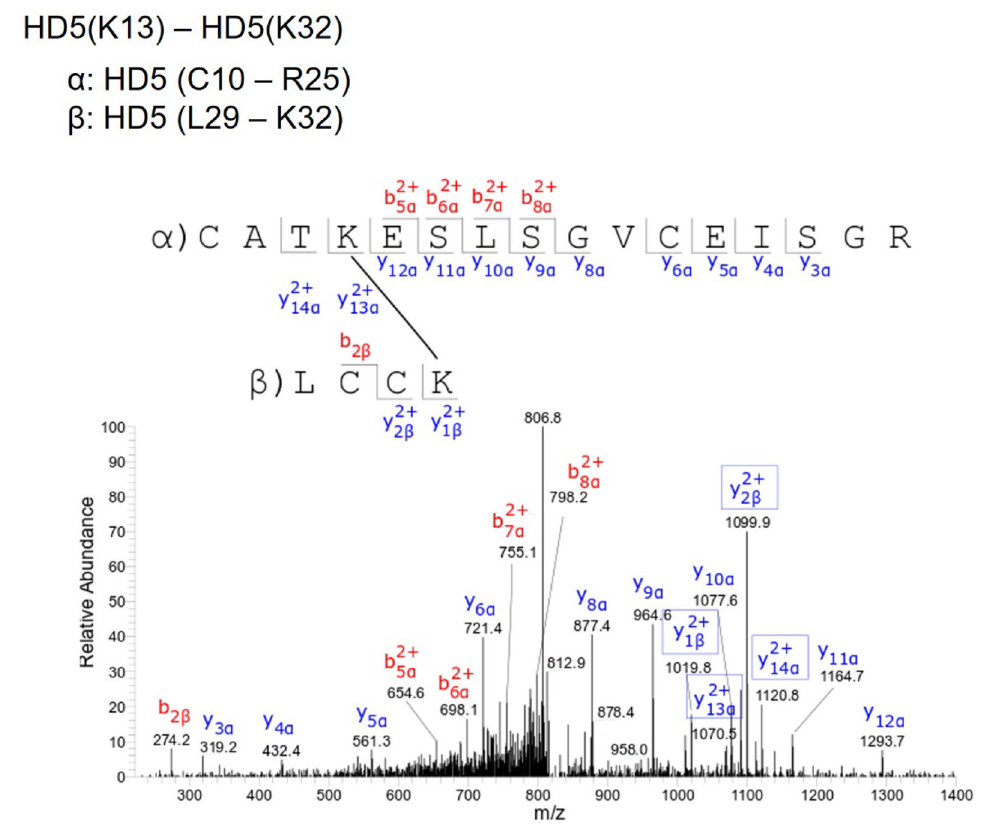
Supplementary Figure 5. Tandem mass spectra of crosslinked peptides identified: Intra-protein crosslinks within HD5-R13K/R32K. Observed b- and y-series ions are shown in each spectrum and the fragment ion species containing the crosslinker plus regions of two crosslinked peptides are boxed. MS/ MS spectrum of a crosslinked peptide (m/z 824.4, +3 charge) between Lys13 and Lys32 of HD5 (Cys10 – Arg25 and Leu29 –